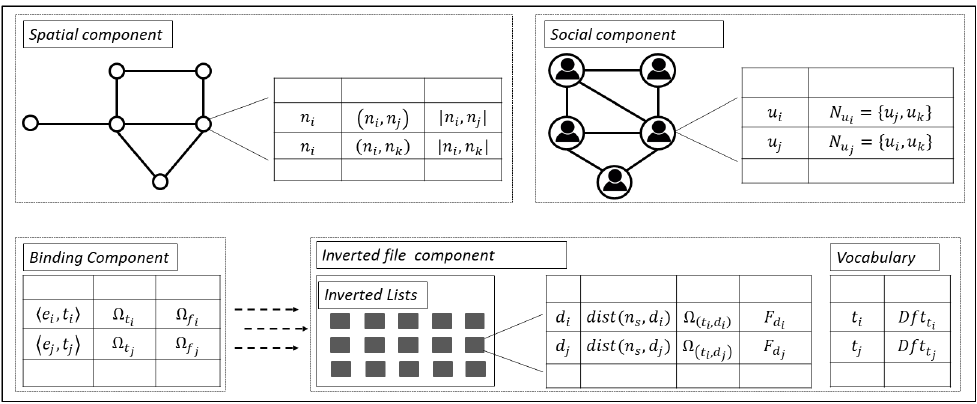
Figure 3. Overview of the proposed indexing